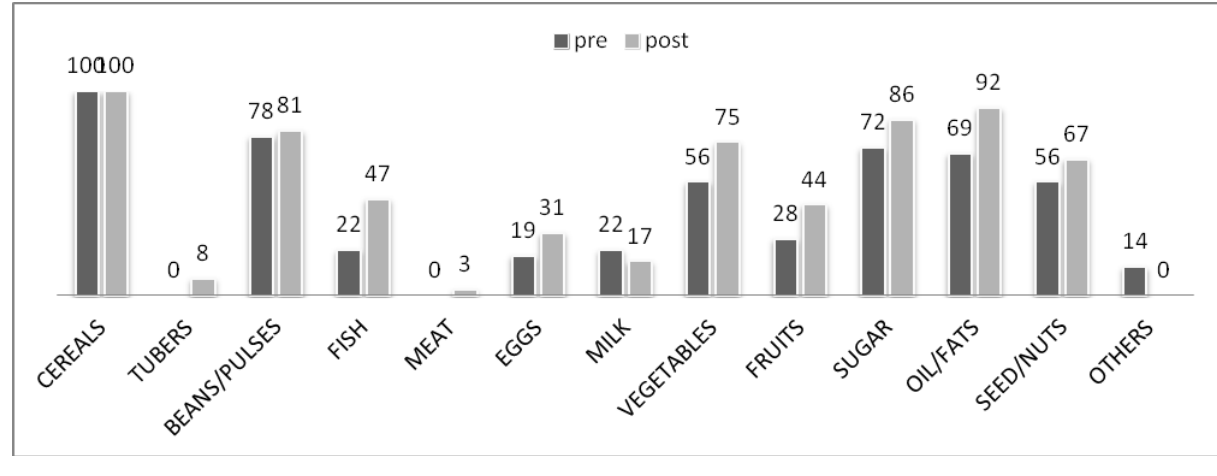
Figure 1. Percentage of children receiving foods at baseline and at follow-up based on 24-h dietary